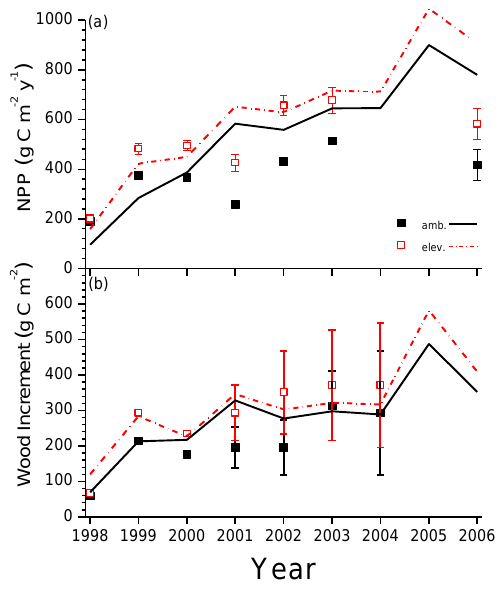
Fig. 10. (a) Annual net primary productivity (NPP) and (b) Fig. 10 gain in biomass measured (symbols) and modelled (lines) from 1998 to 2006 under ambient ( ∼ 374µmolmol − 1 ) vs. elevated ( ∼ 541µmolmol − 1 ) C a at the Rhinelander FACE experiment. Mea- sured NPP from King et al. (2005) to 2003, and from Zak et al. (2011) in 2006, measured wood increments from Kubiske et al. (2006), with error bars representing standard errors from repli- cated measurements ( n = 3). Root exudation (Grant, 1993) was ex- cluded from modelled NPP to simulate biometric